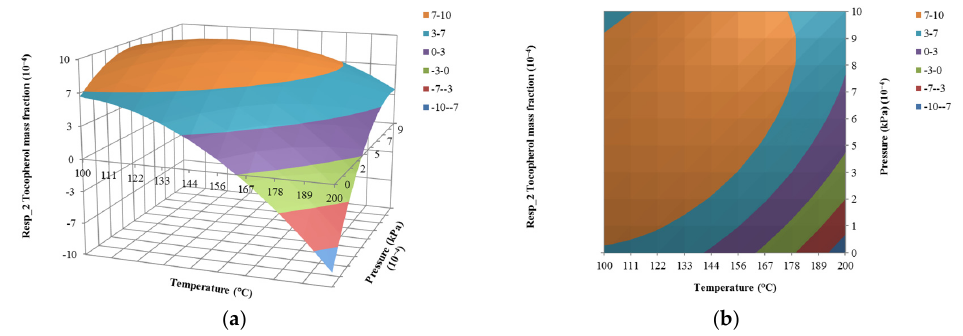
Figure 9. Response surface curve ( a ) and contour plot ( b ) of tocopherol concentration as a function of temperature and pressure.